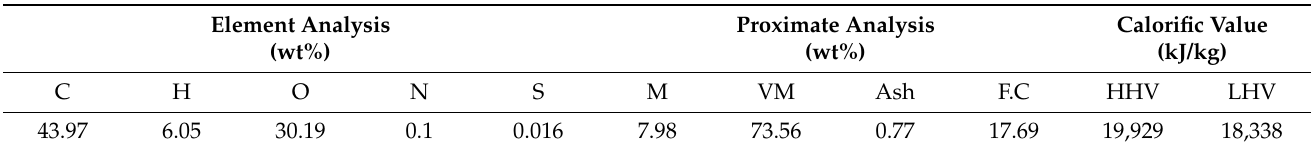
Table 1. Waste wood chip fuel